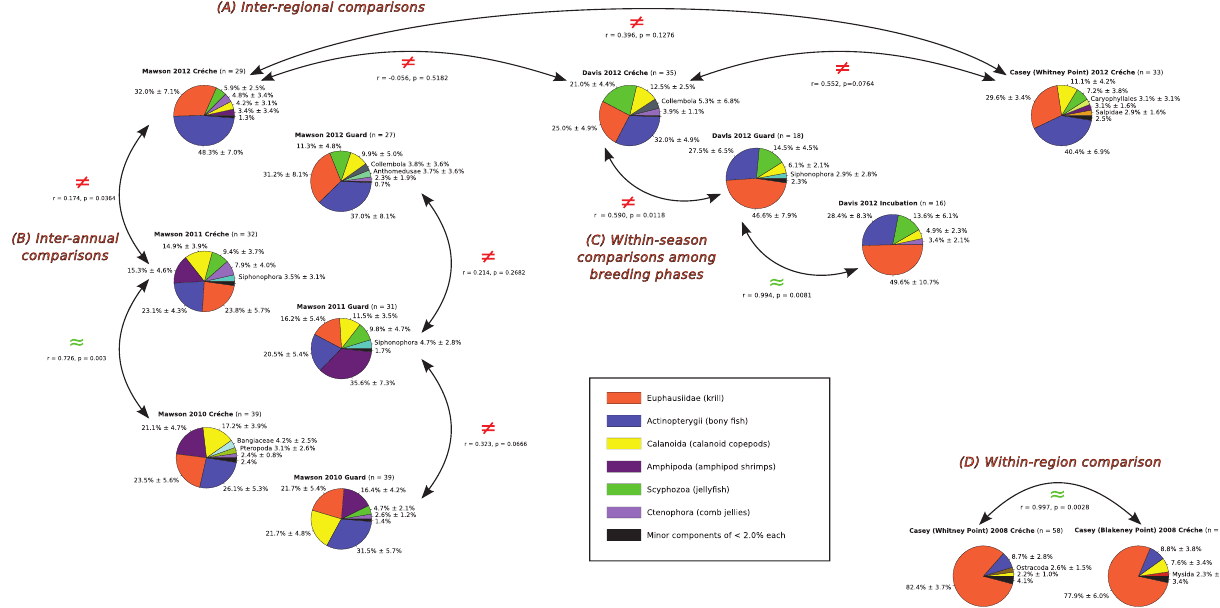
Figure 4. Spatial and temporal comparisons of Ade´lie penguin population diet. Summary pie charts showing the population means of proportions of diet items for all twelve sample sets analysed in this study. The year and sampling location are indicated above each pie chart with the number of scats analysed in brackets after that. Mean percentages of DNA sequences for each group of food species and the standard error of the estimate are given. Four types of comparison among the samples are made. Comparison (A) is of Inter-regional diet differences among samples from Mawson, Davis and Casey collected during the Cre´che phase of the breeding cycle in 2012. A smaller-scale spatial comparison is shown in (D) within the Casey region between two samples collected in 2008. Inter-annual comparisons are shown in (B) for samples collected at Mawson among ‘Cre´che’ samples in 2010,2011 and 2012 and ‘Guard’ samples in 2010, 2011 and 2012. Within-season comparisons are shown in (C) for samples collected at ‘Incubation’,’Guard’ and ‘Cre´che’ phases of the cycle at Davis in 2012. Results of Mantel tests indicating overall similarity or differences between population diet ratios are indicated.